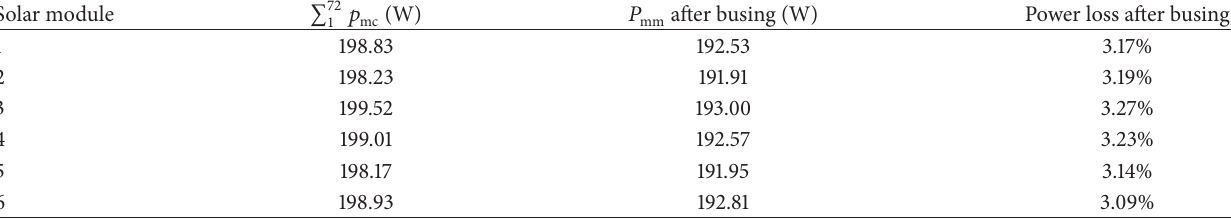
Table 2: The power loss caused by mismatch of solar cells and resistance of ribbon.